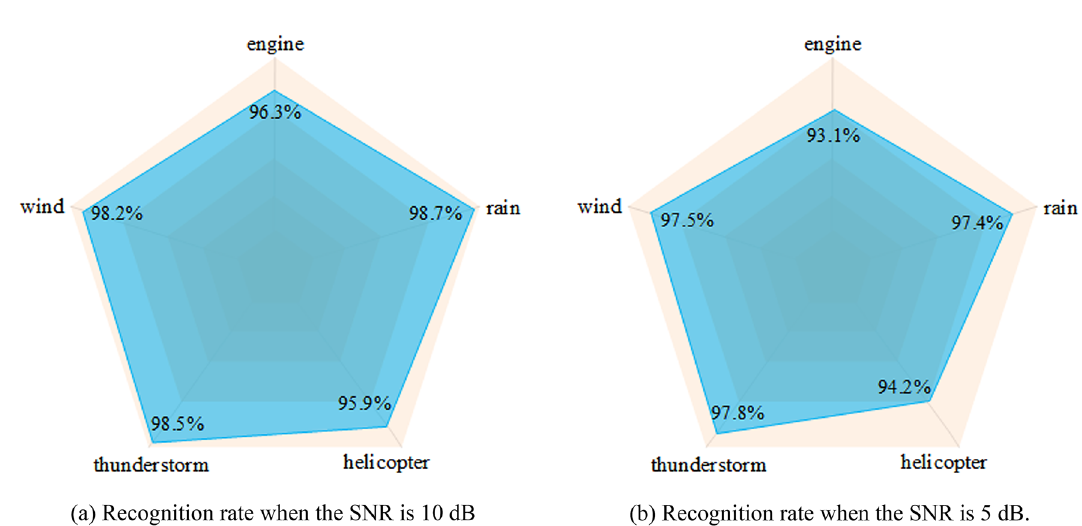
Figure 11. The accuracy and loss of